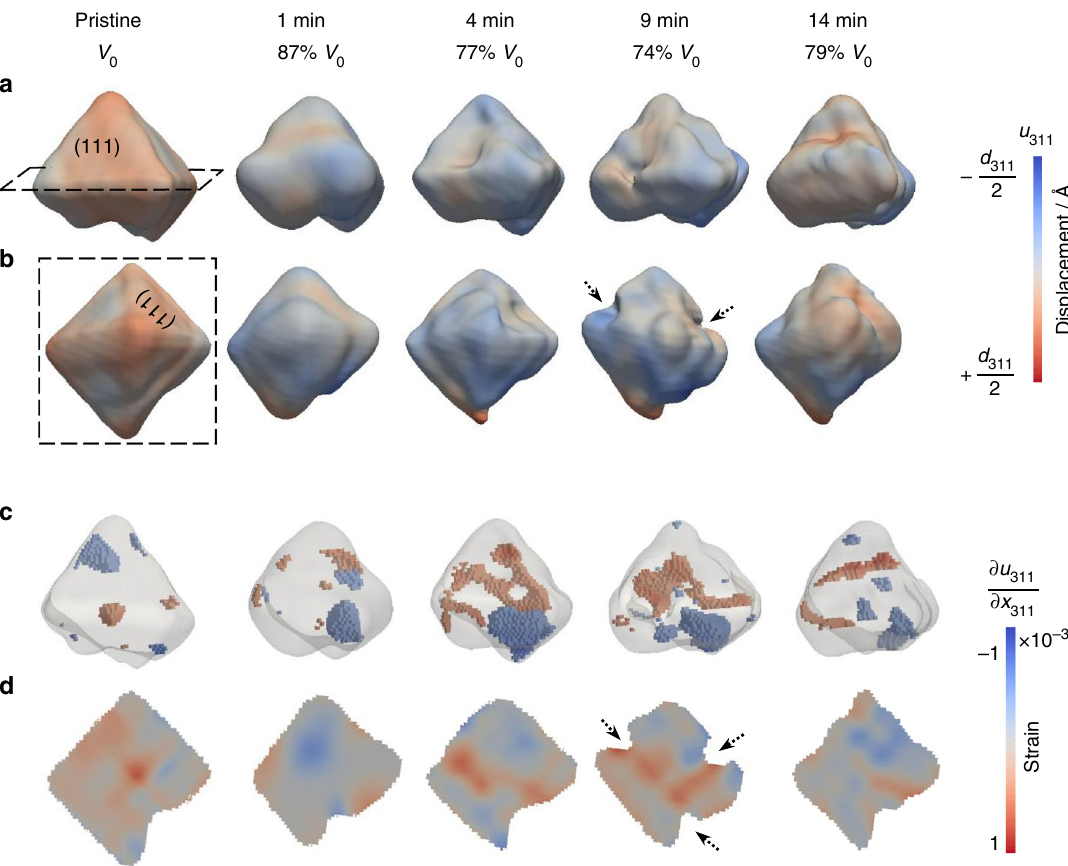
Fig. 1 Dissolution of a pyramid-shaped magnetite crystal observed ex situ after reaction in 0.1 M HCl solution for 14 min. a , b were the 3D volume viewed from two different perspectives at a 30% amplitude threshold. The lattice displacements along the [311] direction were projected on the isosurfaces. c 3D strain structure associated with compressive (blue, strain< − 0.00035 shown in Fig. 3b) and tensile (red, strain > 0.00035 shown in Fig. 3b) strains. d Cross-sectional views of the internal strain fi eld of the plane indicated by the dashed lines in ( a ) and ( b ). Magnetite d 311 = 2.5314 Å 43 . Scale bar, 200